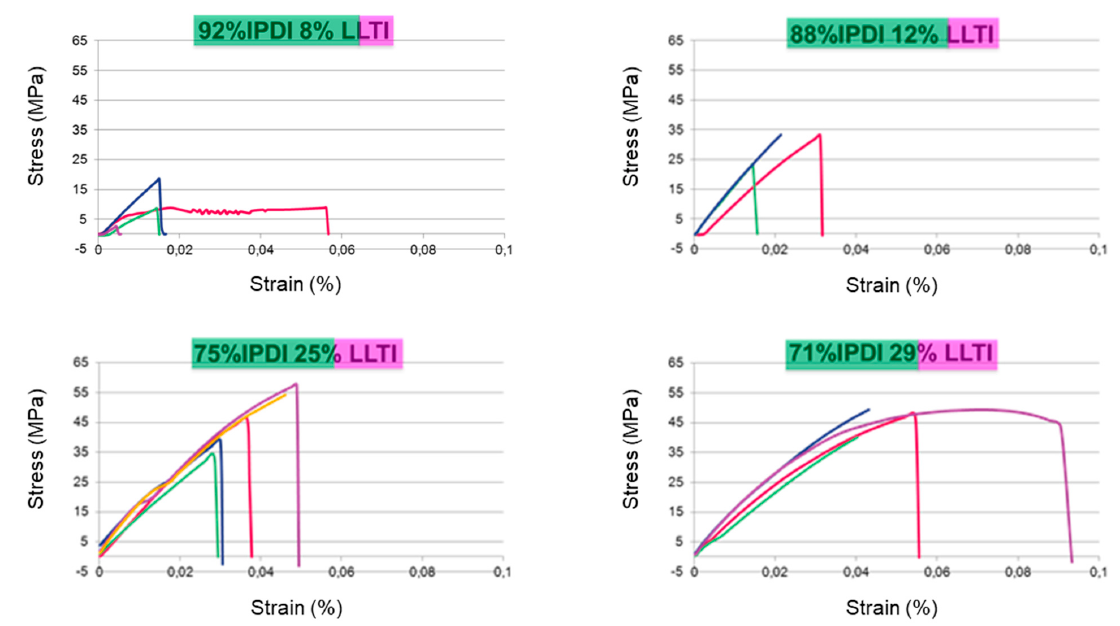
Figure 2. Stress–strain behavior of PUs with different IPDI/LLTI ratios.